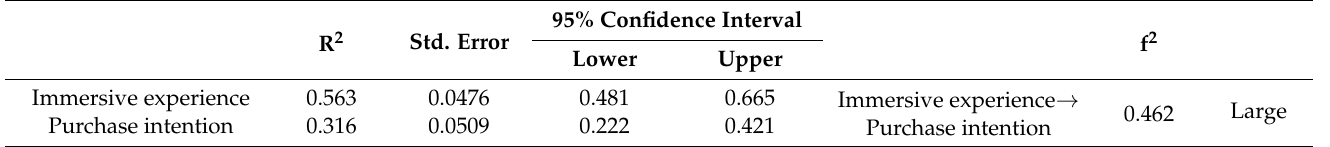
Table 2. R-square and effect size.